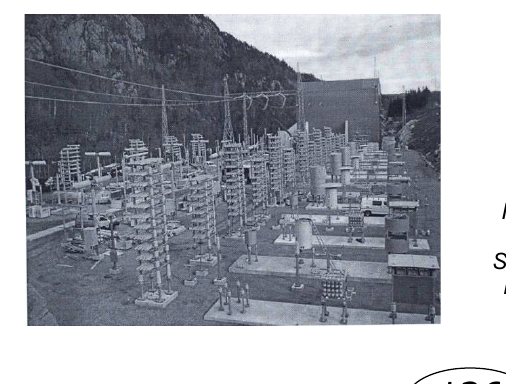
Figure 4 – Appearance of the planned base station базовой